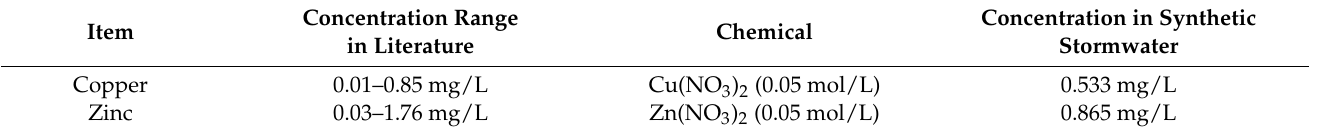
Table 3. Target chemical makeup of synthetic stormwater runoff